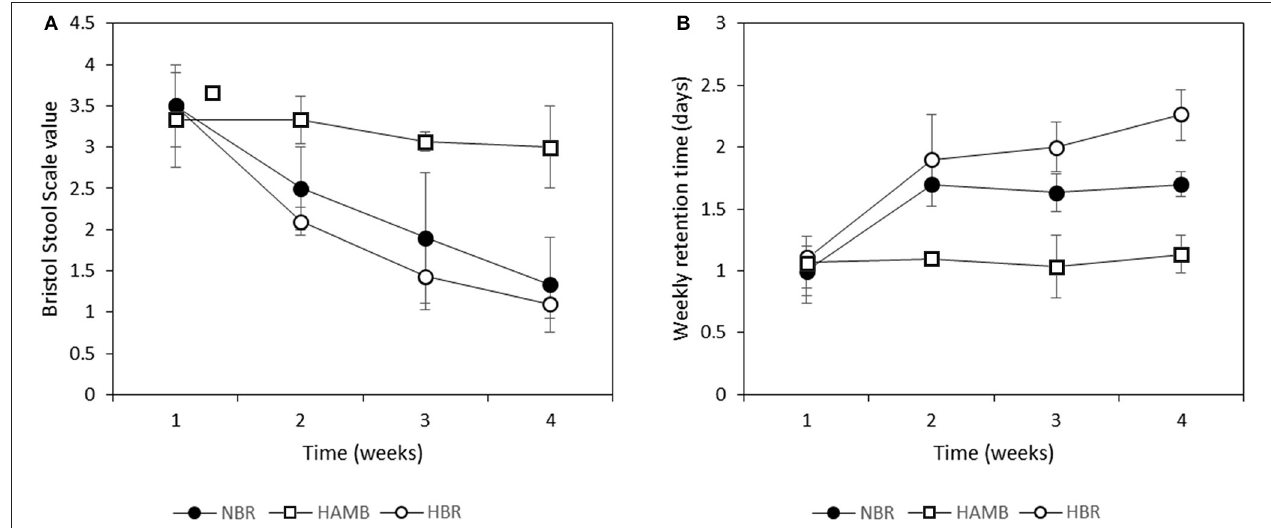
FIGURE 1 | Changes in Bristol stool scale values (A) and retention time (as time between particular defecations) (B) during run-in (week 1) and subsequent 3-week experimental phase.